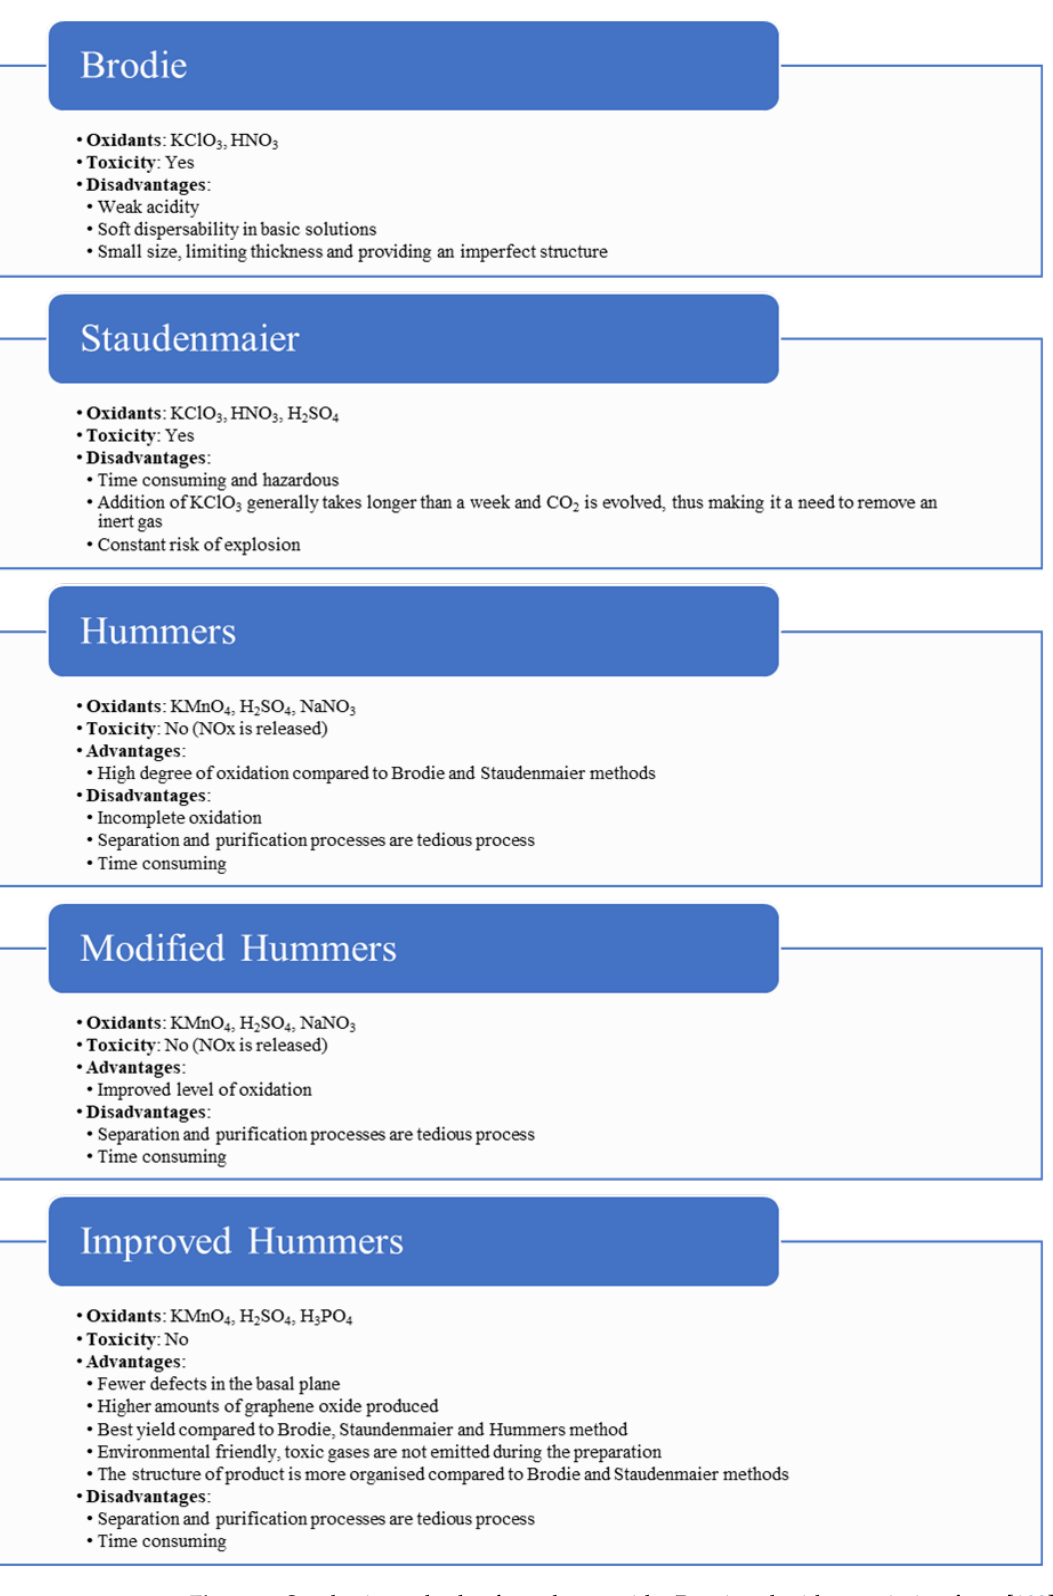
Figure 3. Synthesis methods of graphene oxide. Reprinted with permission from [103]. Copyright 2016 American Chemical Society.